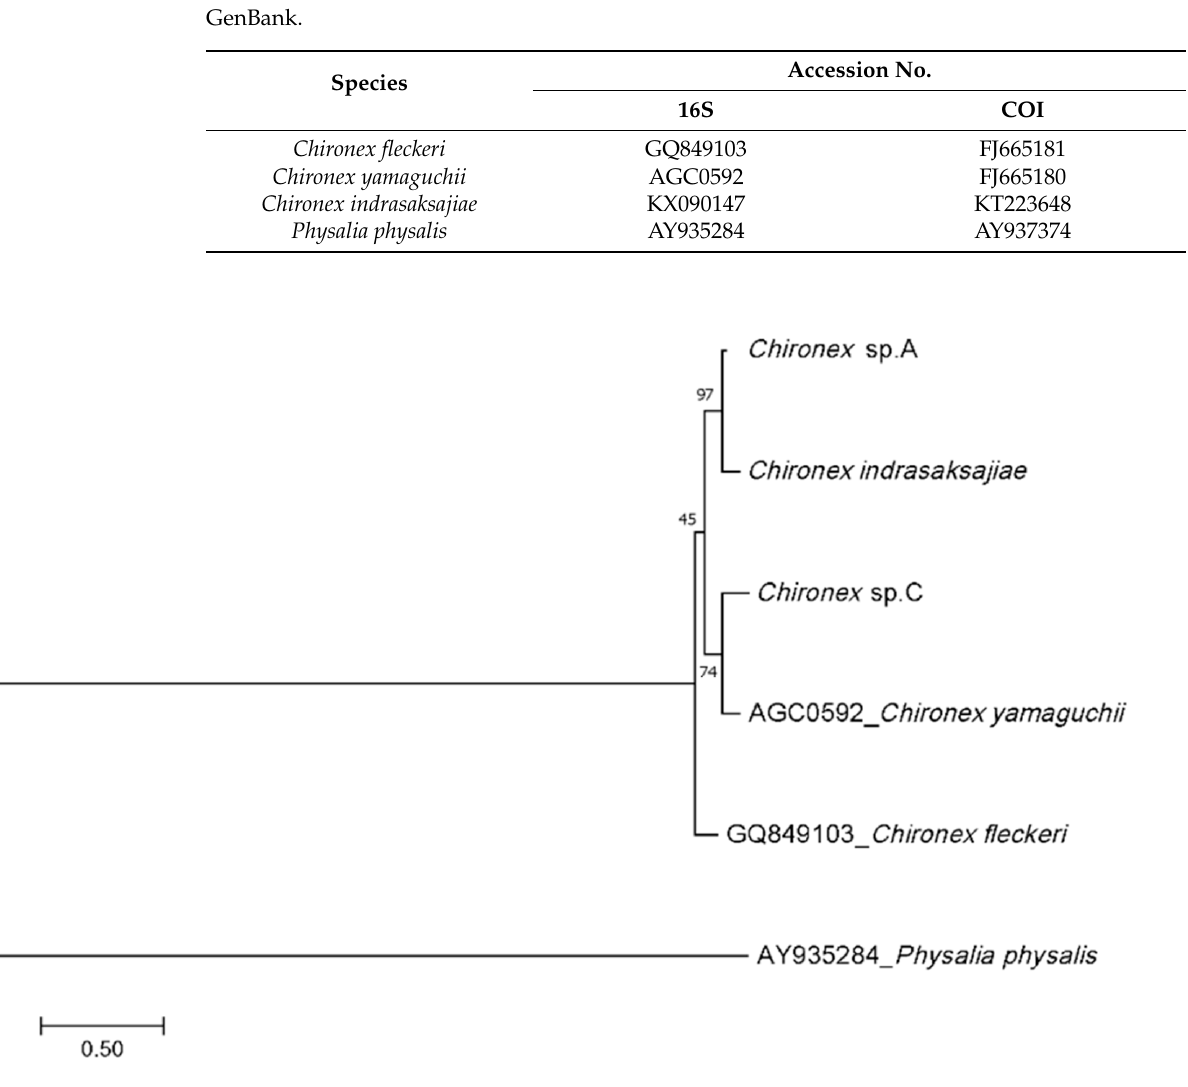
Figure 2. Phylogenetic tree of Chironex species based on the 16S rRNA gene sequences.